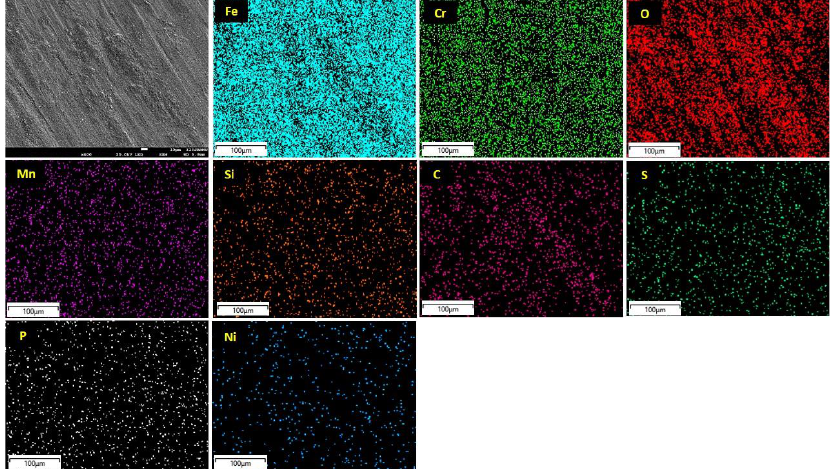
Figure 22. The EDS analysis conducted on the worn surface of the sample manufactured using the CMT-based WAAM process.